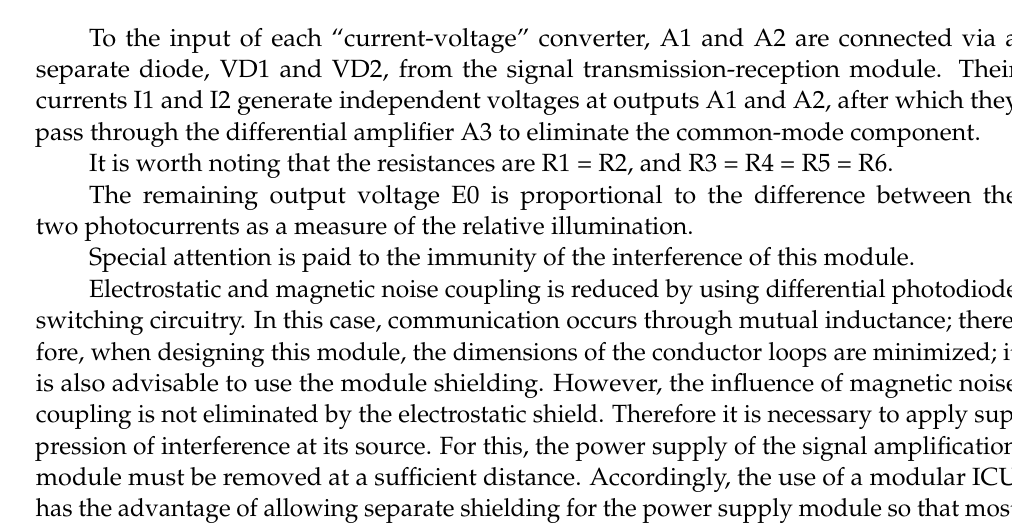
Figure 10. Simplified functional electrical diagram of the SAM signal amplification